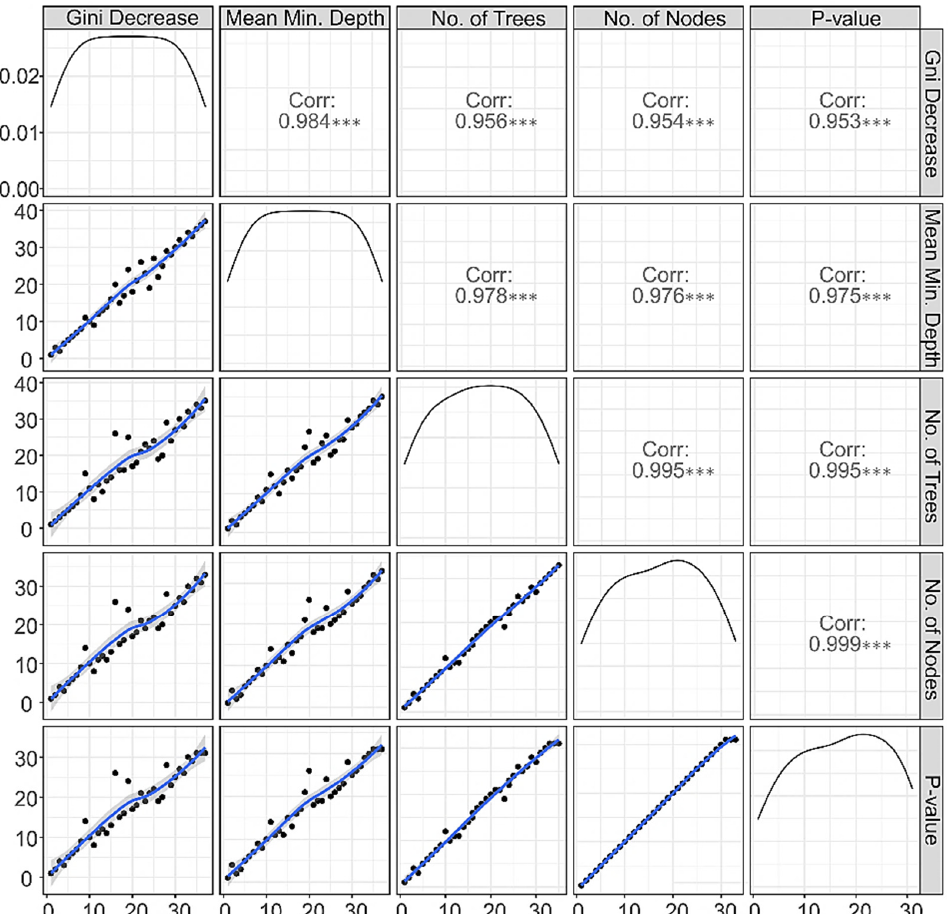
Figure 6. Illustration of rankings of features based on correlation between any two random forest (RF) parameters. The panels in the lower triangle of the grid show the distribution of rankings of all predictor variables with black dots along a blue trend line. The panels in the upper triangle of the grid show correlation coefficients across rankings of any two parameters. It is shown that all RF parameters of importance were found to have very high correlations among each other, suggesting the high reliability of each of these parameters in ranking the importance of features for classifica- tion. The asterisks (***) represents that the correlations were highly significant ( p < 0.001).